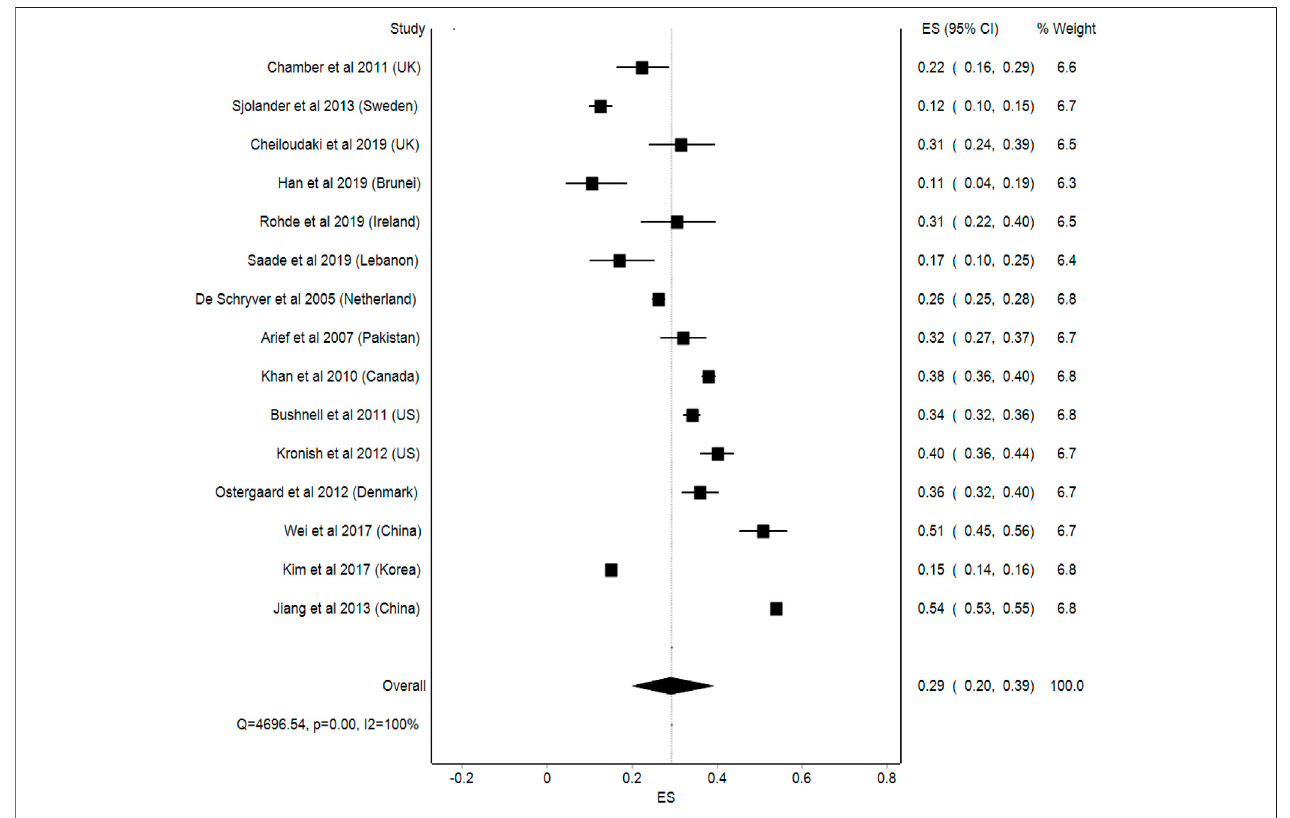
FIGURE 5 | Pooled prevalence of medication adherence in stroke